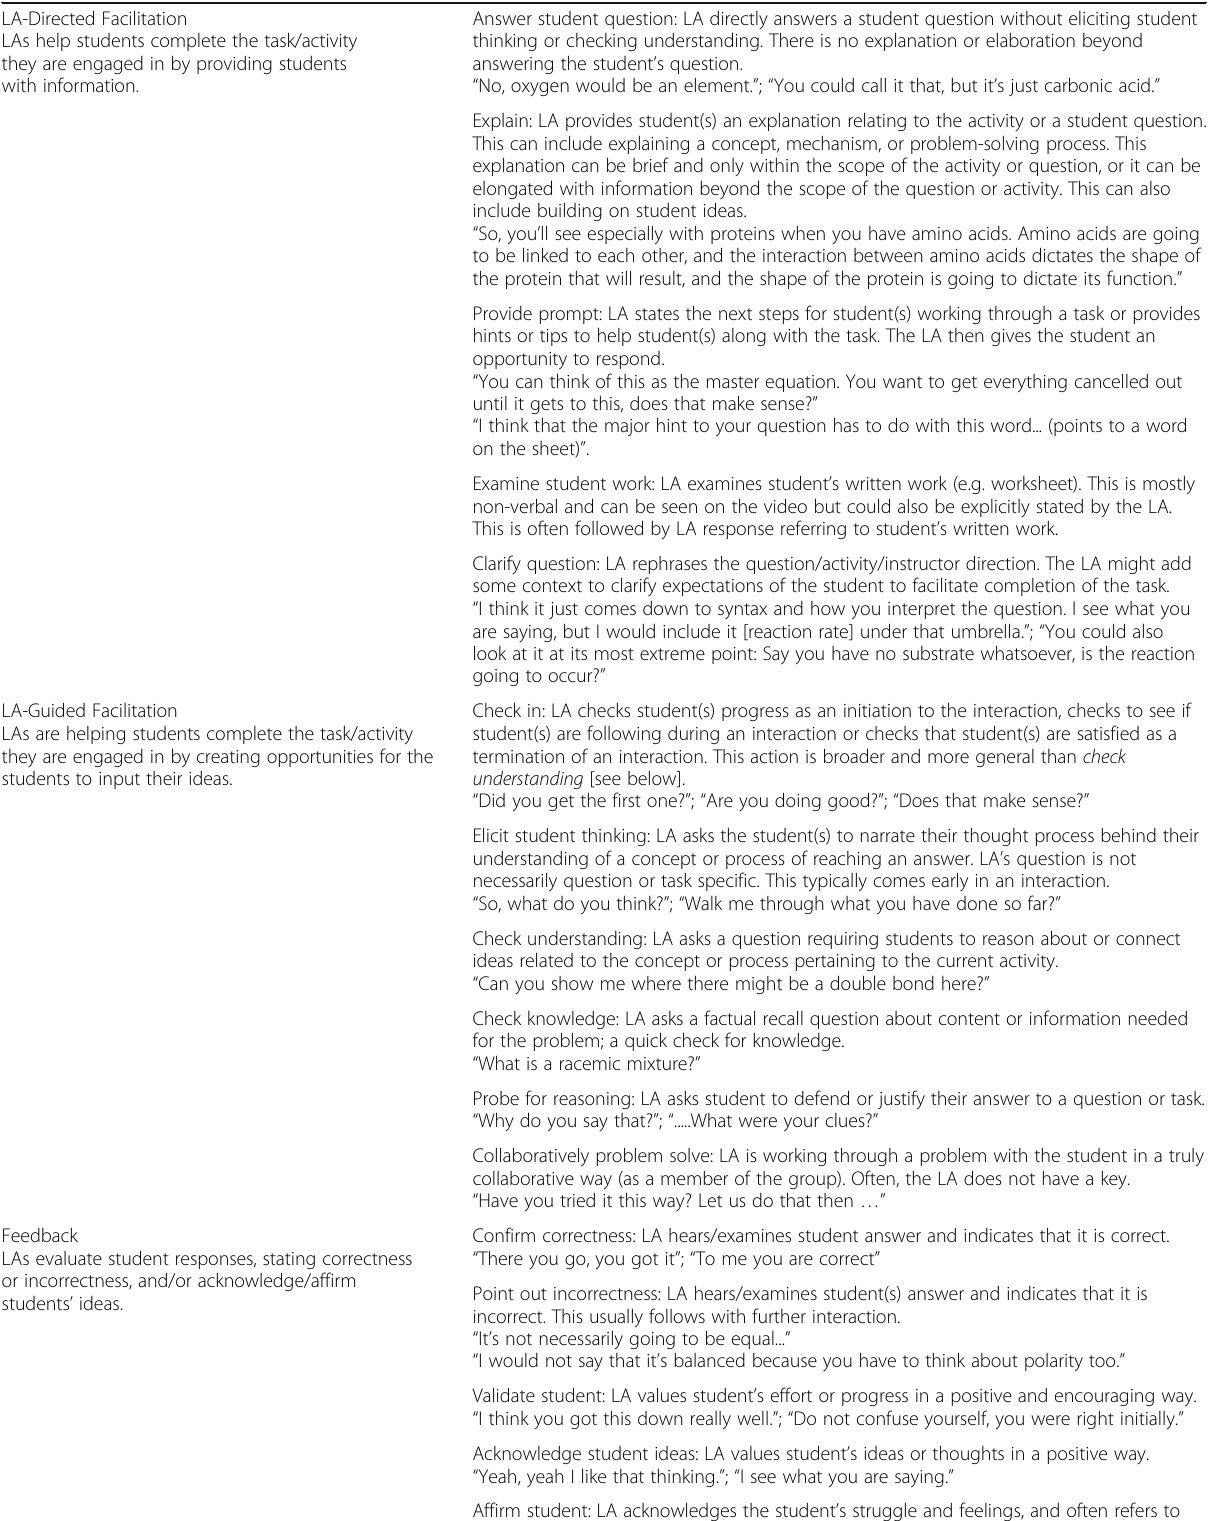
Table 2 ATLAs framework Parent code Primary code: descriptors and LA quotes LA-Directed Facilitation LAs help students complete the